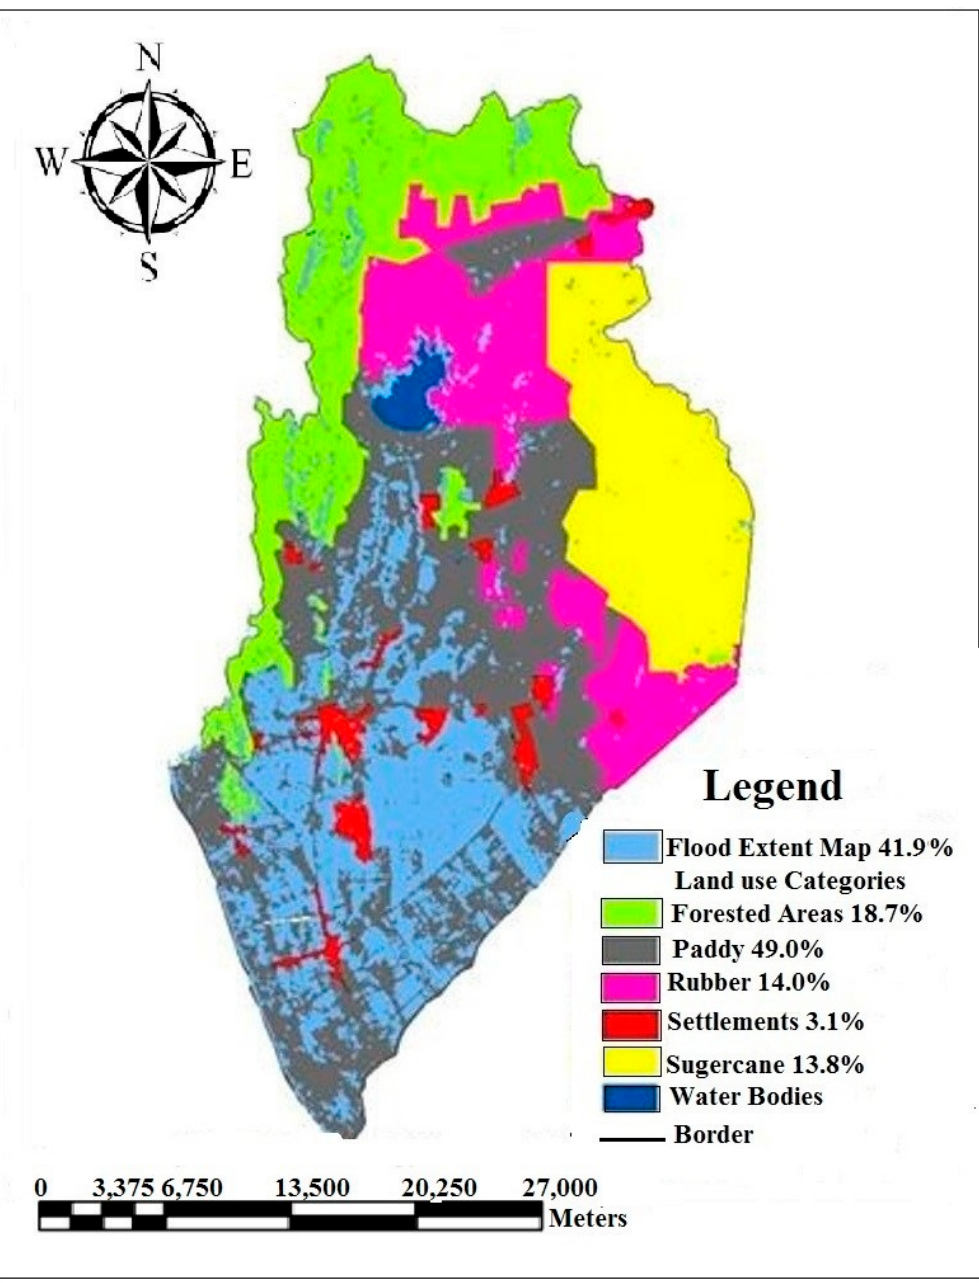
Figure 9. Super imposition of the flood extent model over the land use layer.